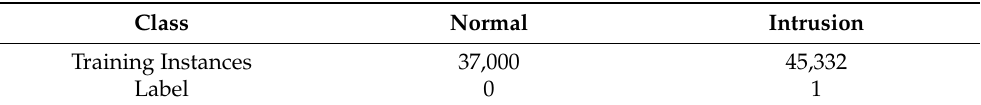
Table 2. Training